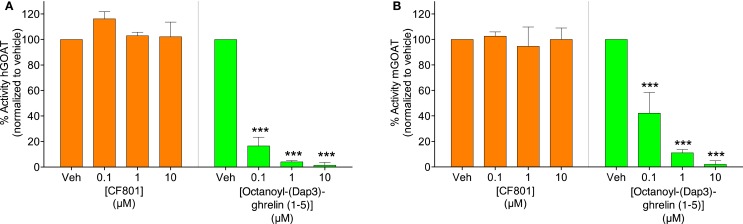
Percent activity of human GOAT (A) and mouse GOAT (B) (obtained from membrane fractions from Sf9 cells expressing hGOAT and mGOAT, resepectively) when exposed to CF801 and octanoyl-(Dap3)-ghrelin (1–5)–NH2 using a fluorescence-based microsomal assay. GSSFLCAcDan was used as an acylation target with fluorescence measured by reverse phase HPLC with fluorescence detection. CF801 had no effect on either hGOAT or mGOAT acylation activity, while octanoyl-(Dap3)-ghrelin (1–5)–NH2 dose-dependently reduced GOAT activity. All values are expressed as mean ± SEM. ***p < 0.001 compared to vehicle control.